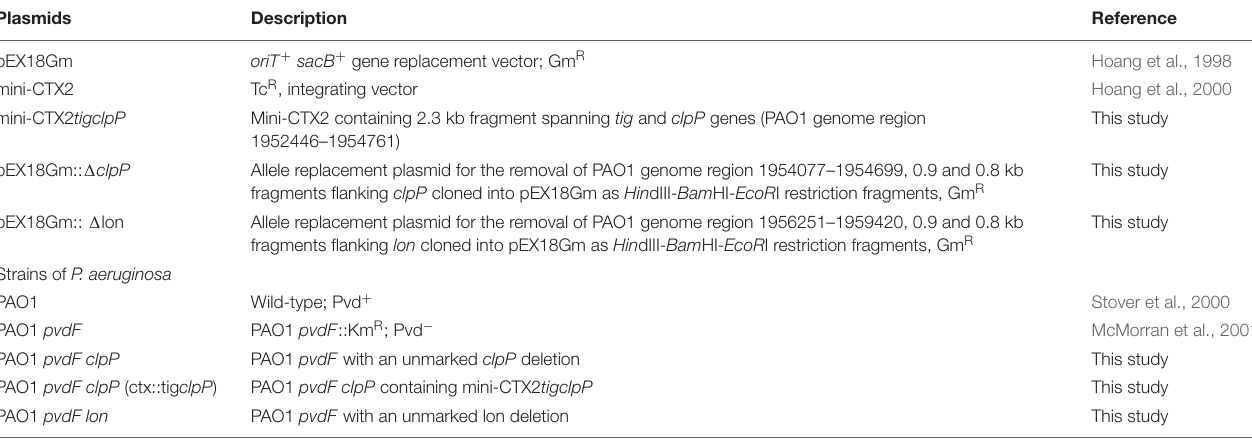
TABLE 1 | Plasmids and strains of Pseudomonas aeruginosa used in this study.